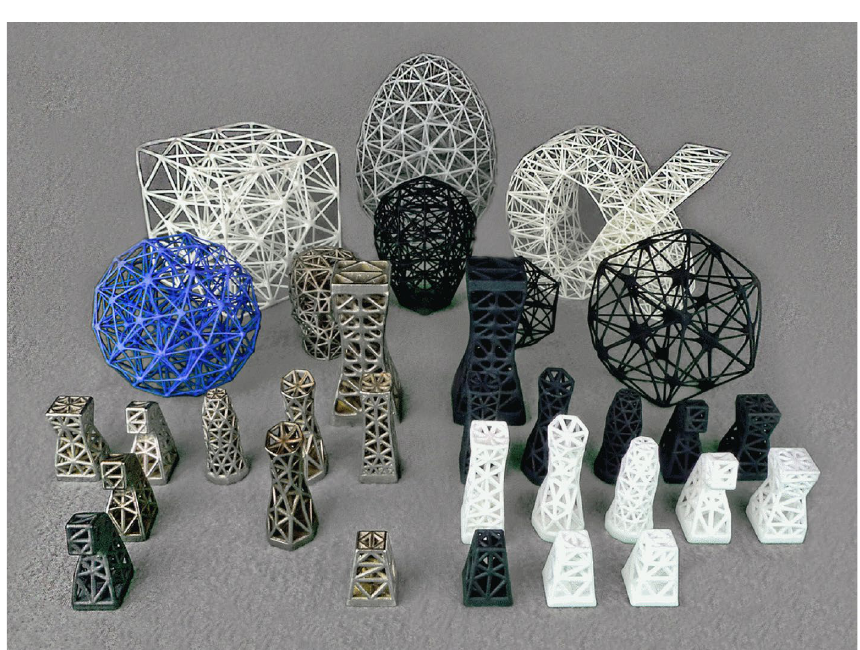
Figure 5. A menagerie of AM-printed HGon structures with wide-ranging simple and complex shapes. Several materials and processes are shown including SLS (sintered) alloys of steel, bronze, brass, aluminum, titanium and plastics e.g. nylon and ABS, Jet-fusion, and SLA printed resin. See the “Appendix” for further information and 3D-VR views of these and other